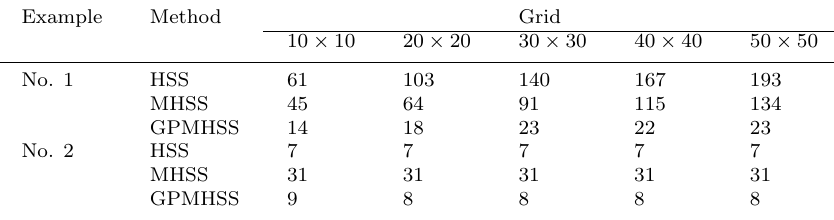
Table 3. The comparison of iteration number.